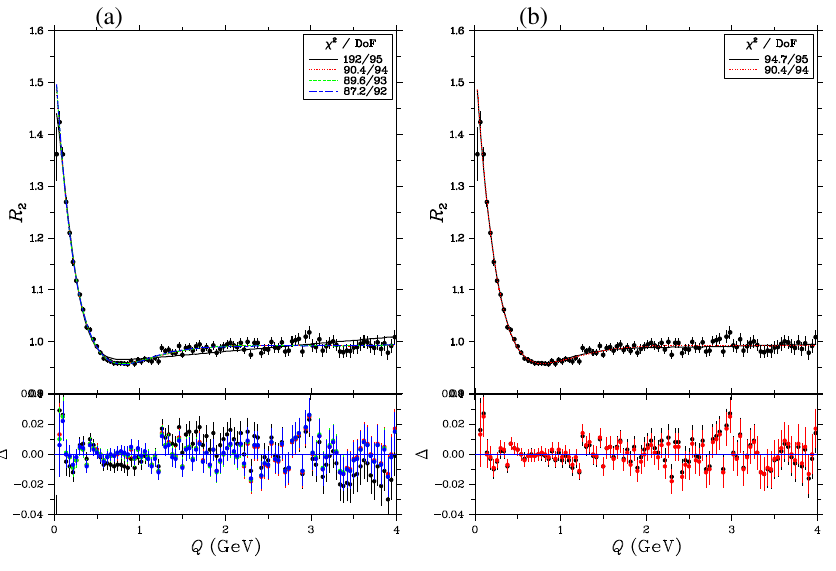
Figure 2. (a) Symmetric Lévy fit for two-jet events up to orders 0 through 3 Lévy polynomials; (b) First-order Lévy polynomial fit (black) for two-jet events compared to the τ -model fit